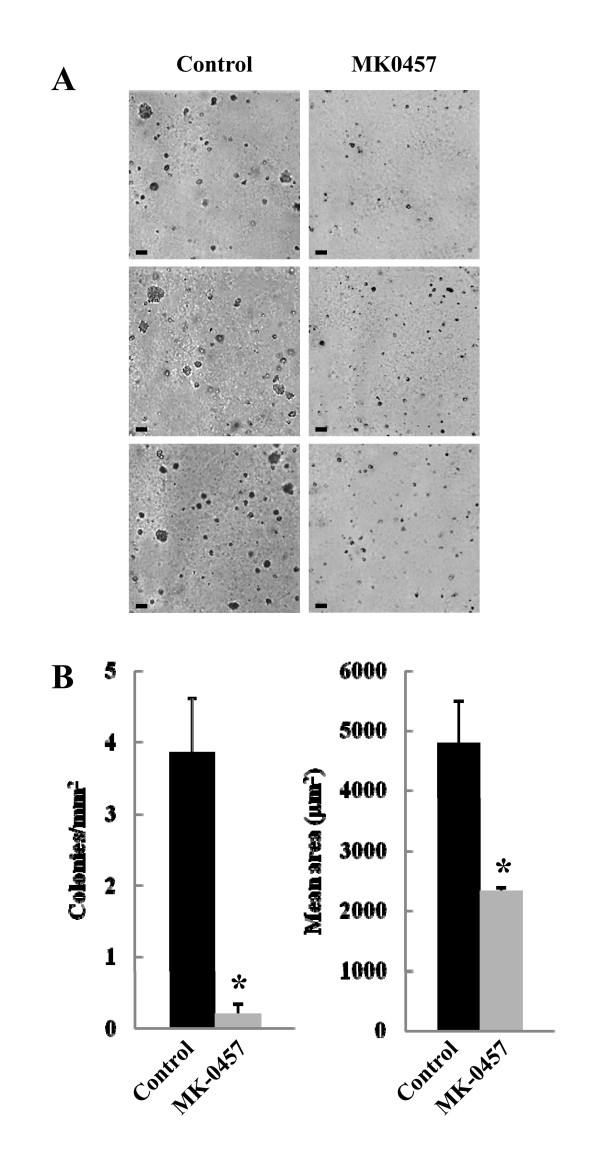
Effects of the MK-0457 on TT cell colony formation in soft agar. (A) TT cells were plated in soft agar onto 3.5 cm Petri dishes in the absence or in the presence of MK-0457 (200 nM). Treated and non-treated plates were photographed after three weeks of incubation. The colony size was determined using the MetaVue software and those larger than 50 μm in diameter were scored. Photographs reported in the figure are representative of one out of three similar experiments each performed in triplicate. Scale bar, 100 μm. (B) Effects of MK-0457 on the number and size of TT colonies in soft agar. Data reported represent the mean ± SEM of three independent experiments. *p < 0.001